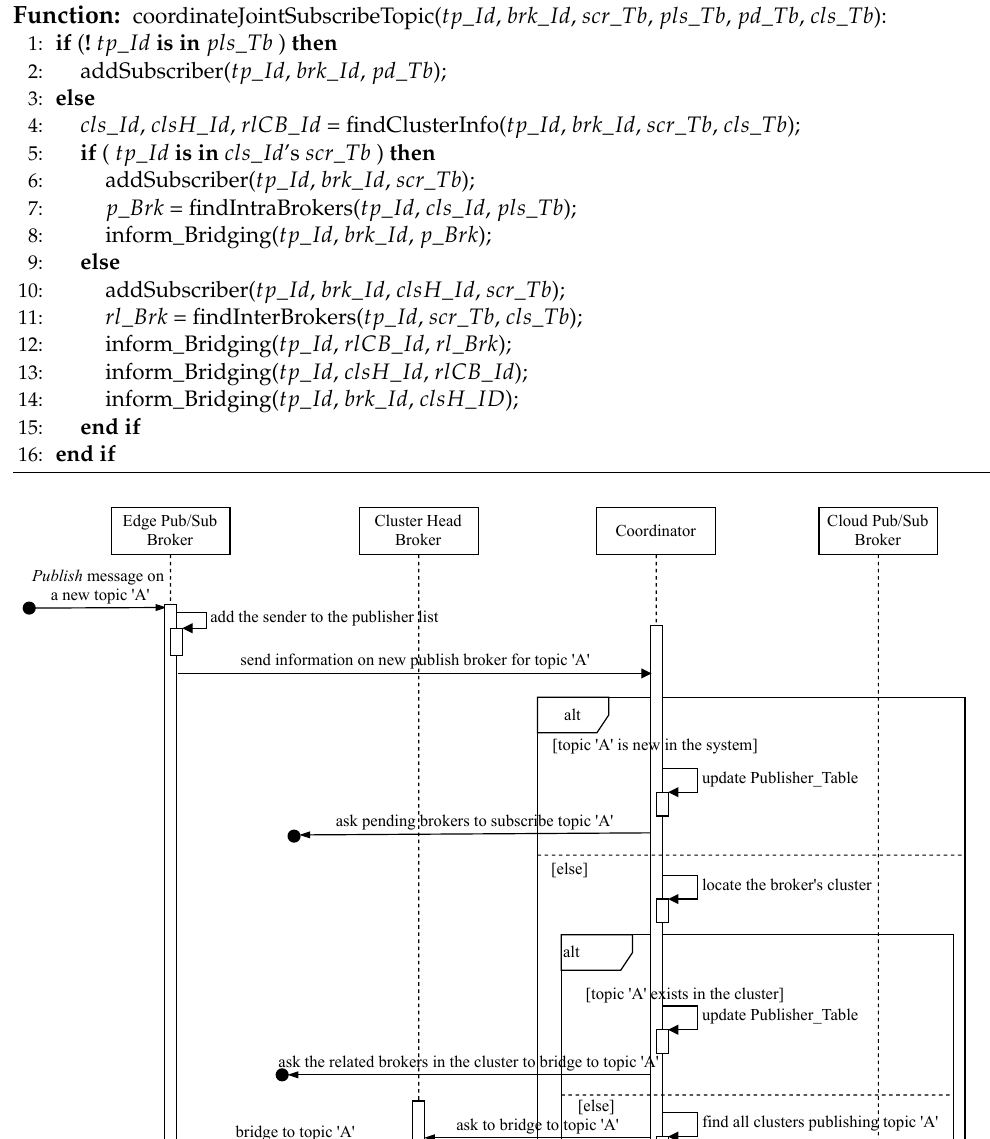
Algorithm 2 Bridging joint Subscribe topic channels among broker clusters.